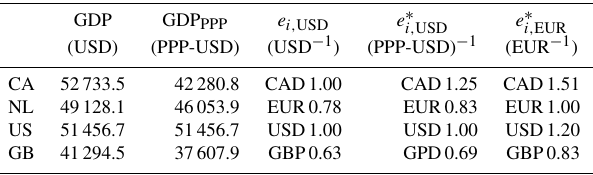
Table 2. GDP per capita, purchasing power parity (PPP) GDP per capita, and mean exchange rates ( e i, USD ) of 2012 (World Bank, 2016) for Canada, the Netherlands, and the USA, as well as the PPP- adjusted exchange rates e ∗ and e ∗ . The PPP-adjusted ex- i, EUR i, USD change rates give the amount of money in the currency of the coun- try having the same purchasing power as USD1.00 and EUR1.00,